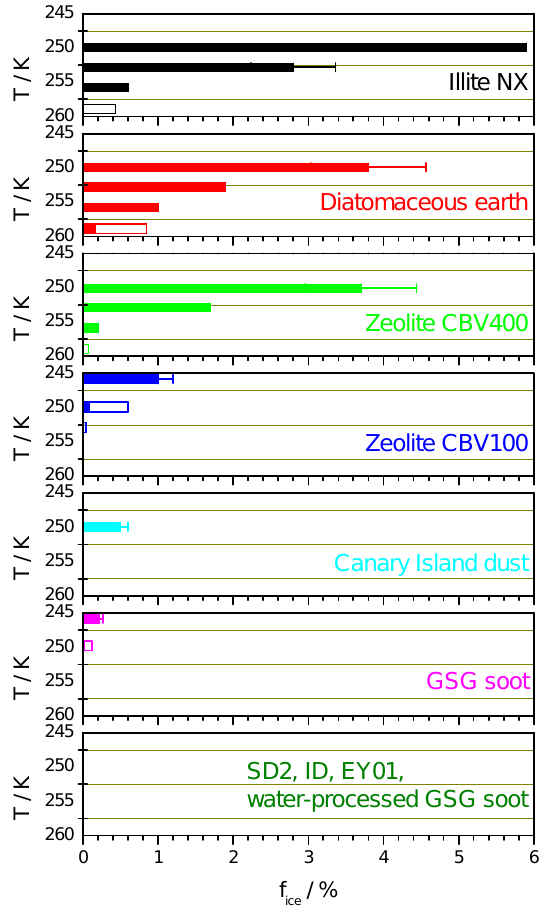
Figure 4. Temperature-dependent ice-active fractions after pre- activation for different aerosol types in the depositional ice growth mode (filled bars) and the condensational ice growth mode (bars without colour filling). Exemplary error bars denote the uncertainty of ± 20% for f ice . The estimated detection limit for f ice is 0.04%. For the SD2, ID, EY01, and water-processed GSG soot particles, the pre-activation efficiency is below this